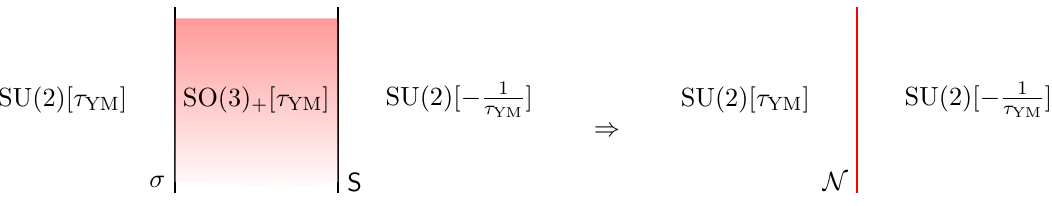
Figure 1 . At τ YM = i , the SU(2) theory has a non-invertible defect N , which can be understood as the composition of a defect σ implementing gauging of the Z (1) with an invertible S